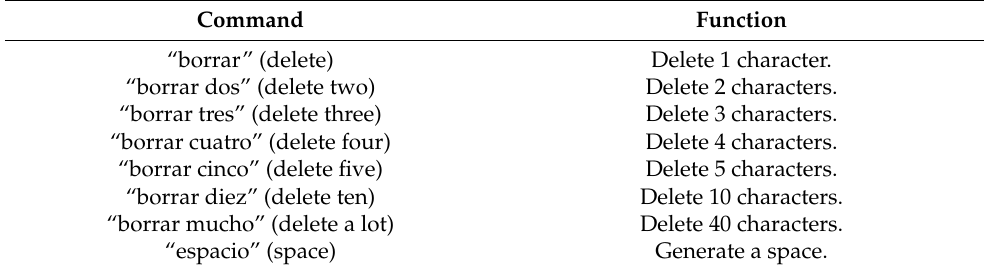
Table 1. Predefined dictation commands. Command